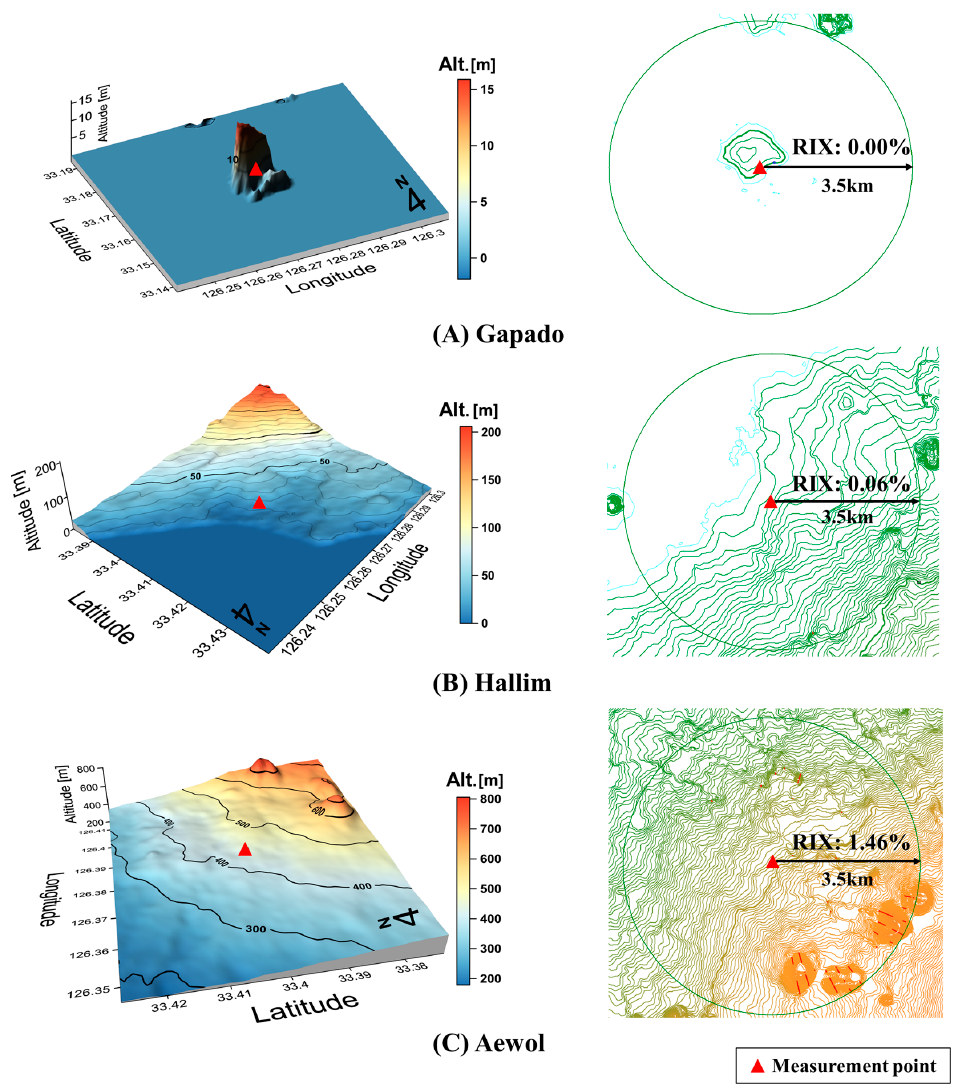
Figure 2. 3D images and RIX analysis for the measurement sites.